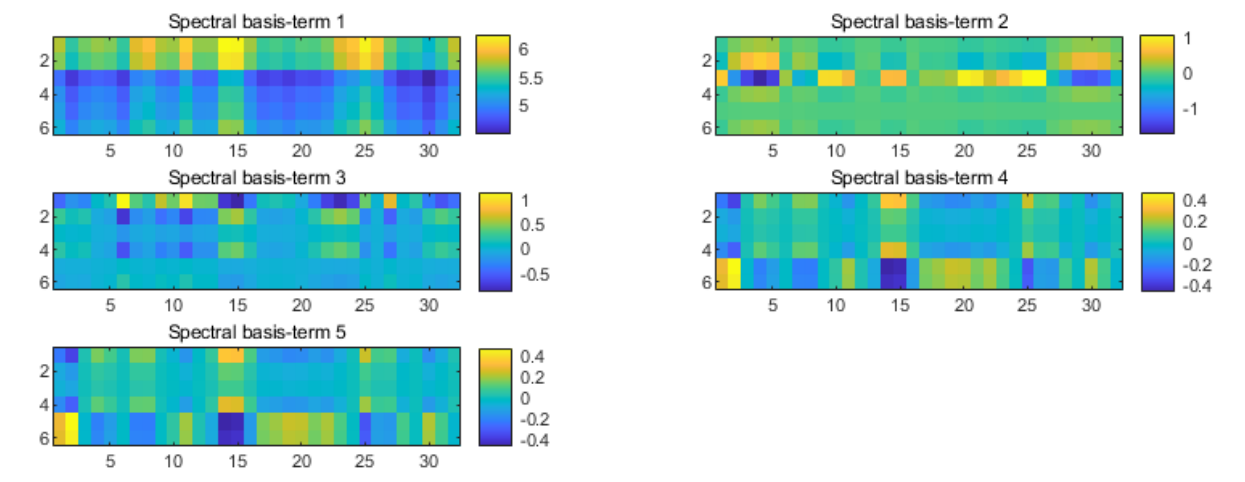
Figure 4. Spectral basic terms of the resistivity model are shown in Figure 2. The color bar is on log10 scale, and the y-axis is the number of each layer.